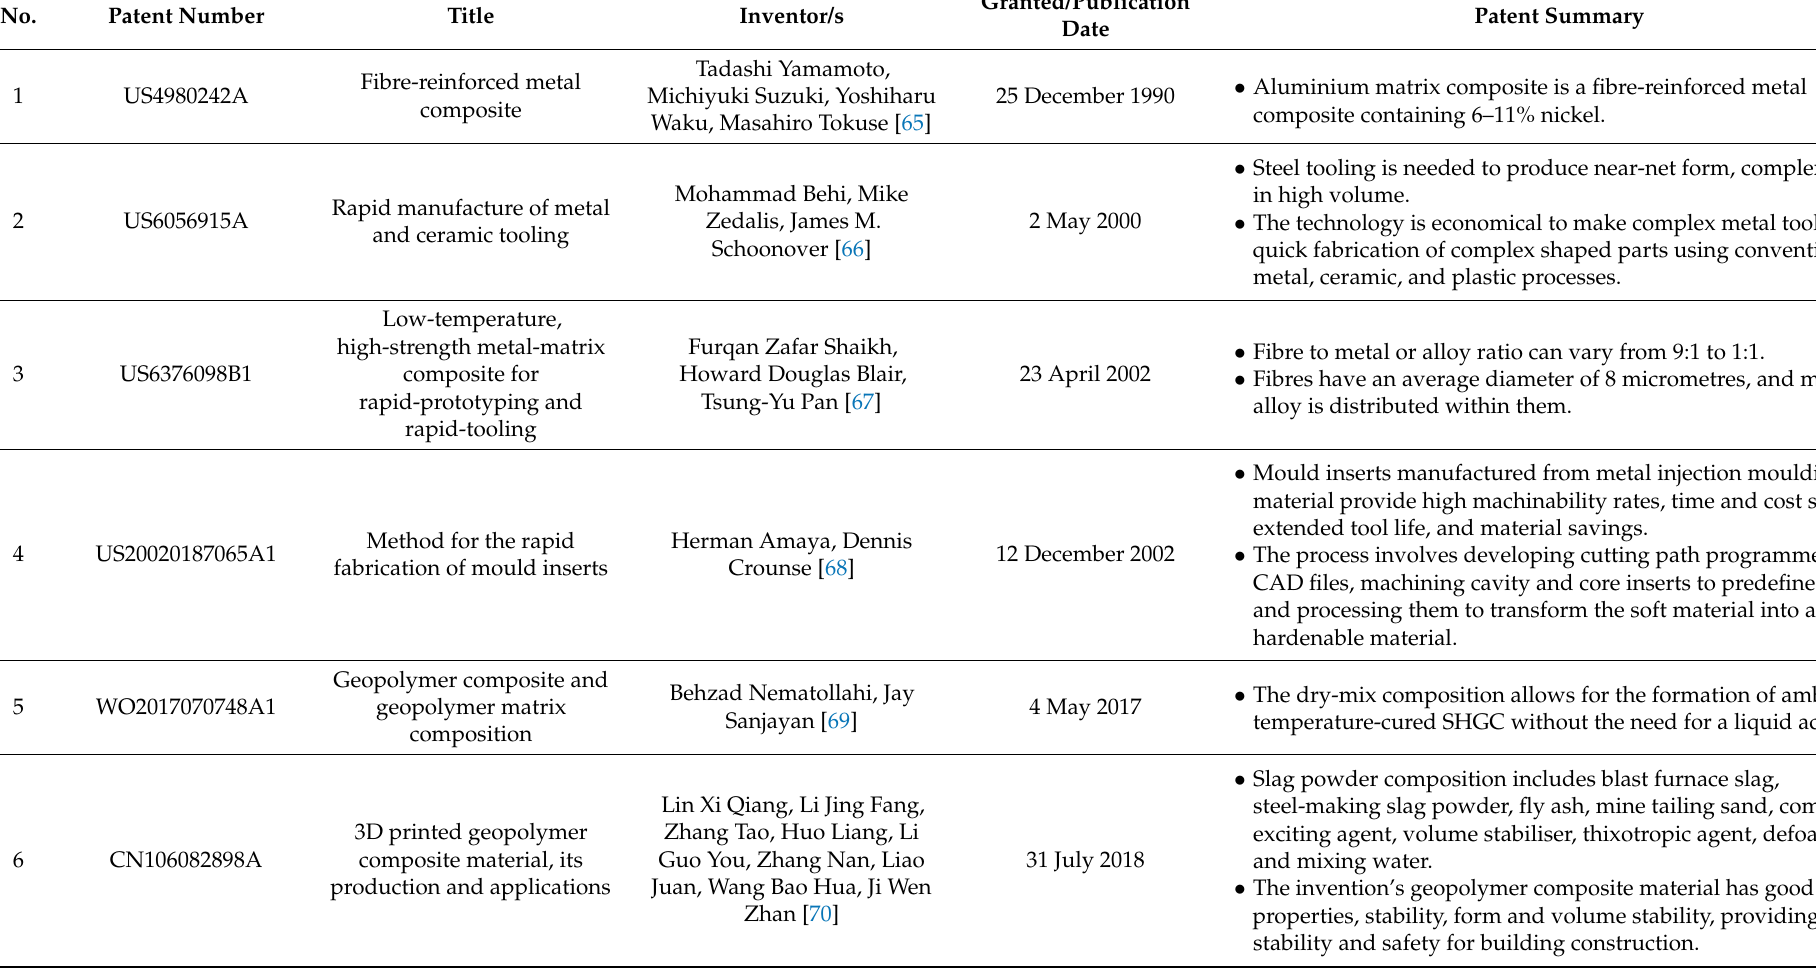
Table 1. Six patents granted/published from 1990 to February